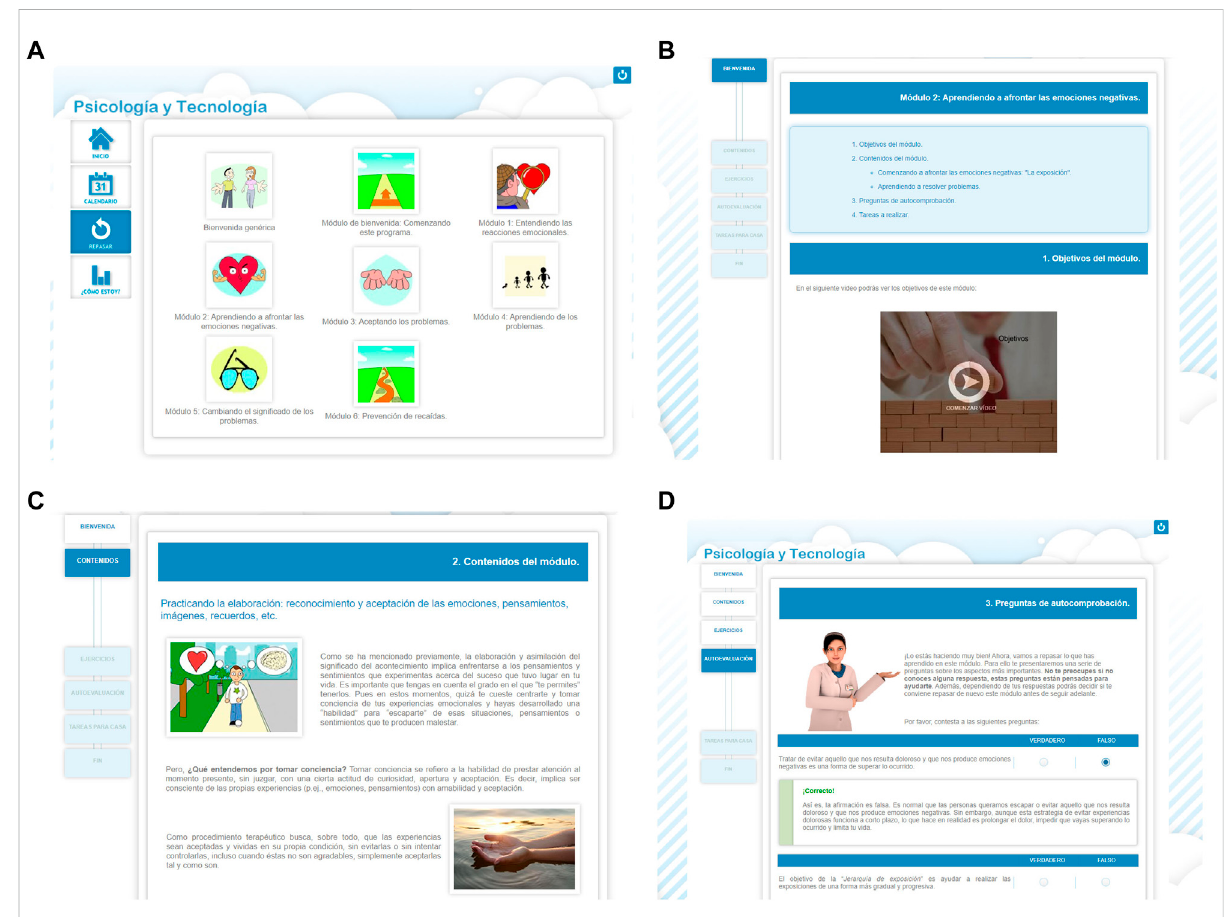
FIGURE 1 Intervention screenshots: (A) main menu; (B) agenda and therapeutic goals; (C) therapeutic contents; (D) self-assessment